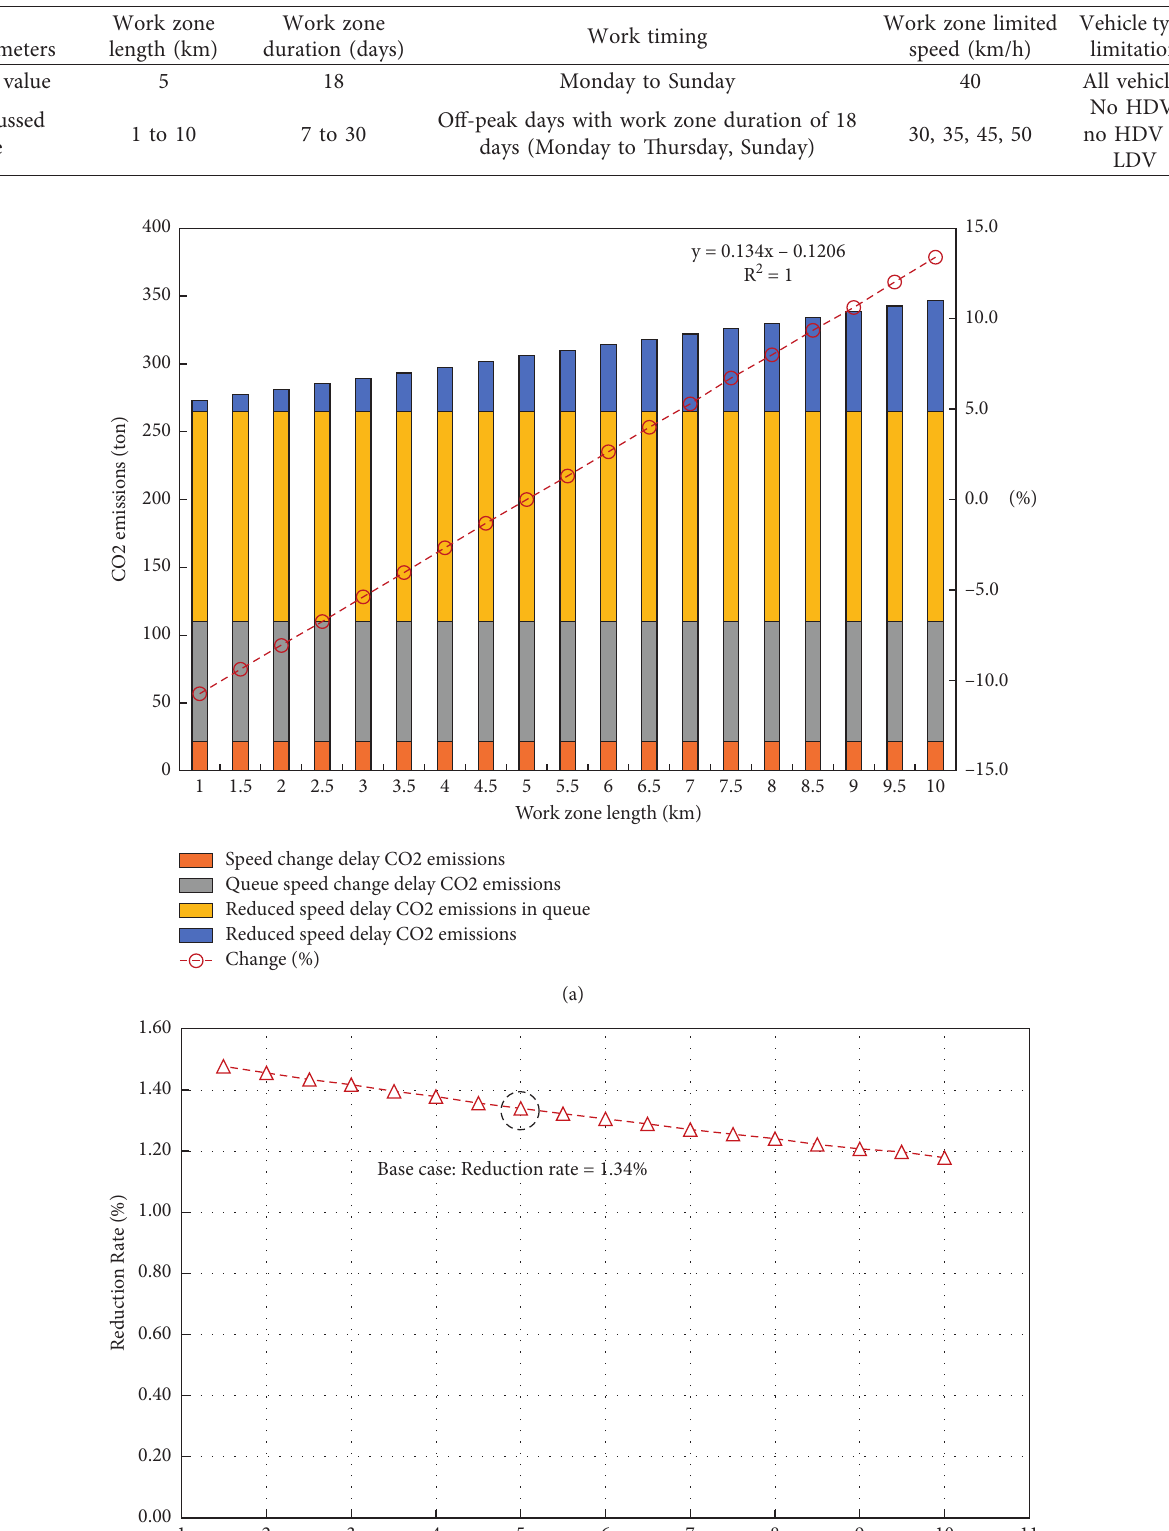
2 emissions calculation (2018).